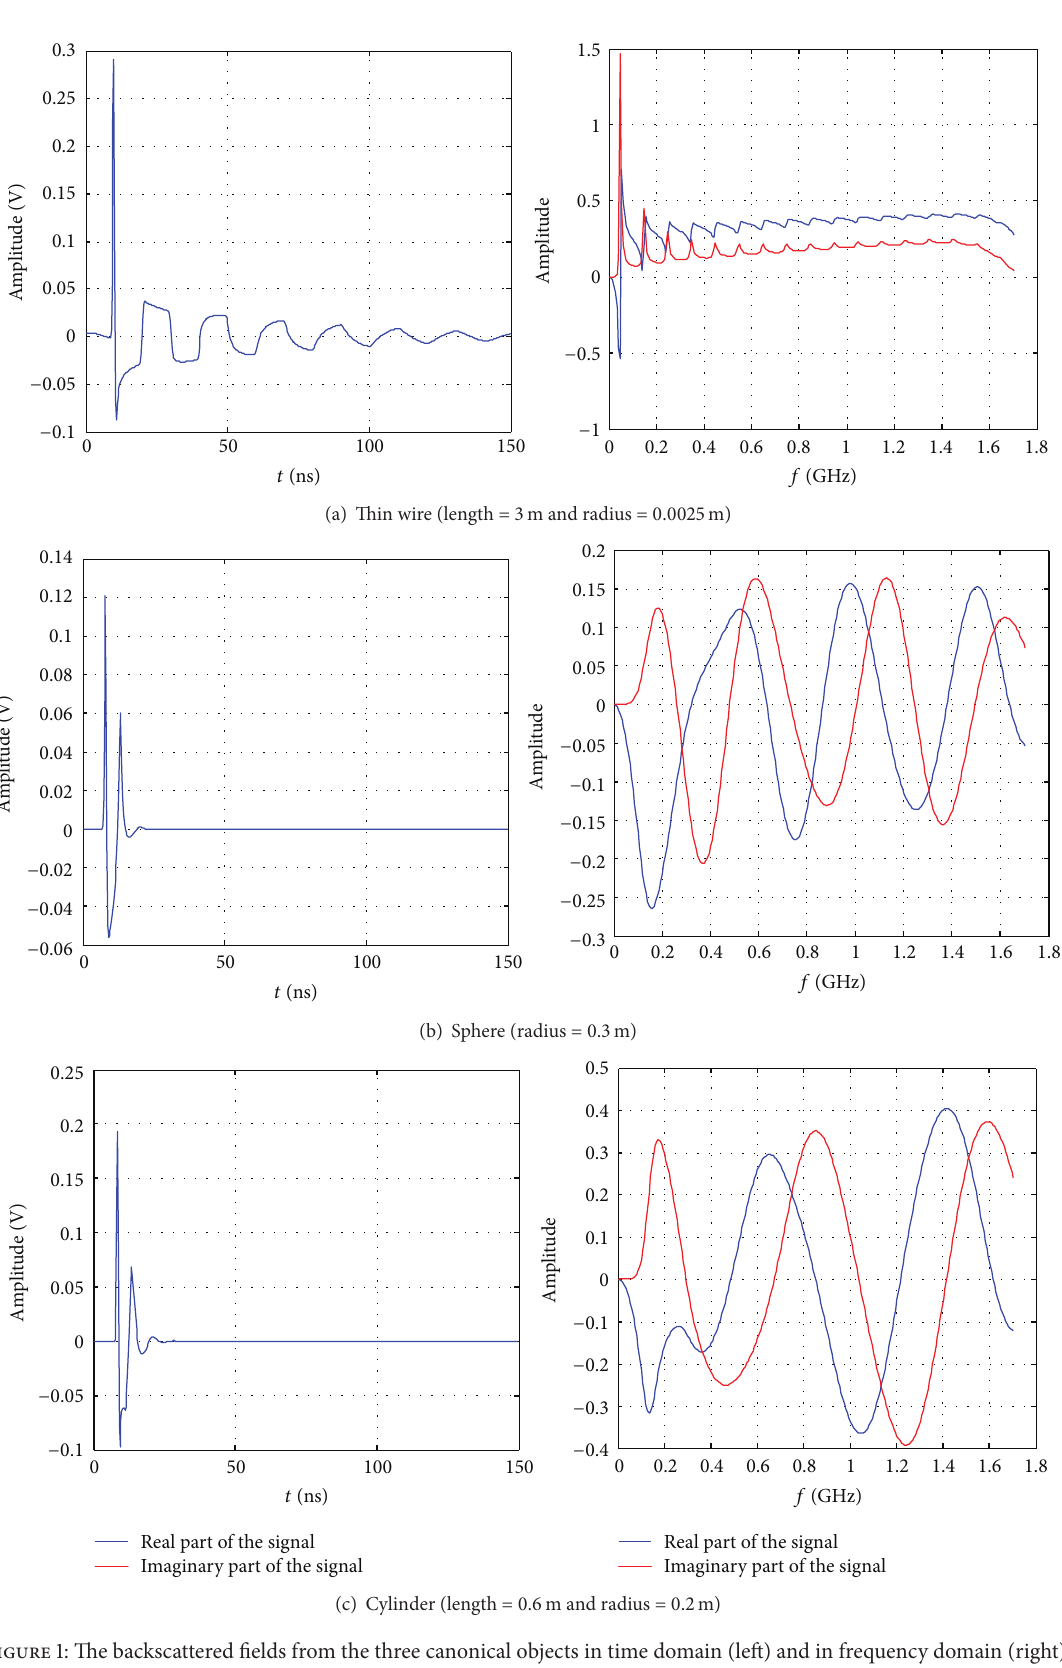
Figure 1: The backscattered fields from the three canonical objects in time domain (left) and in frequency domain